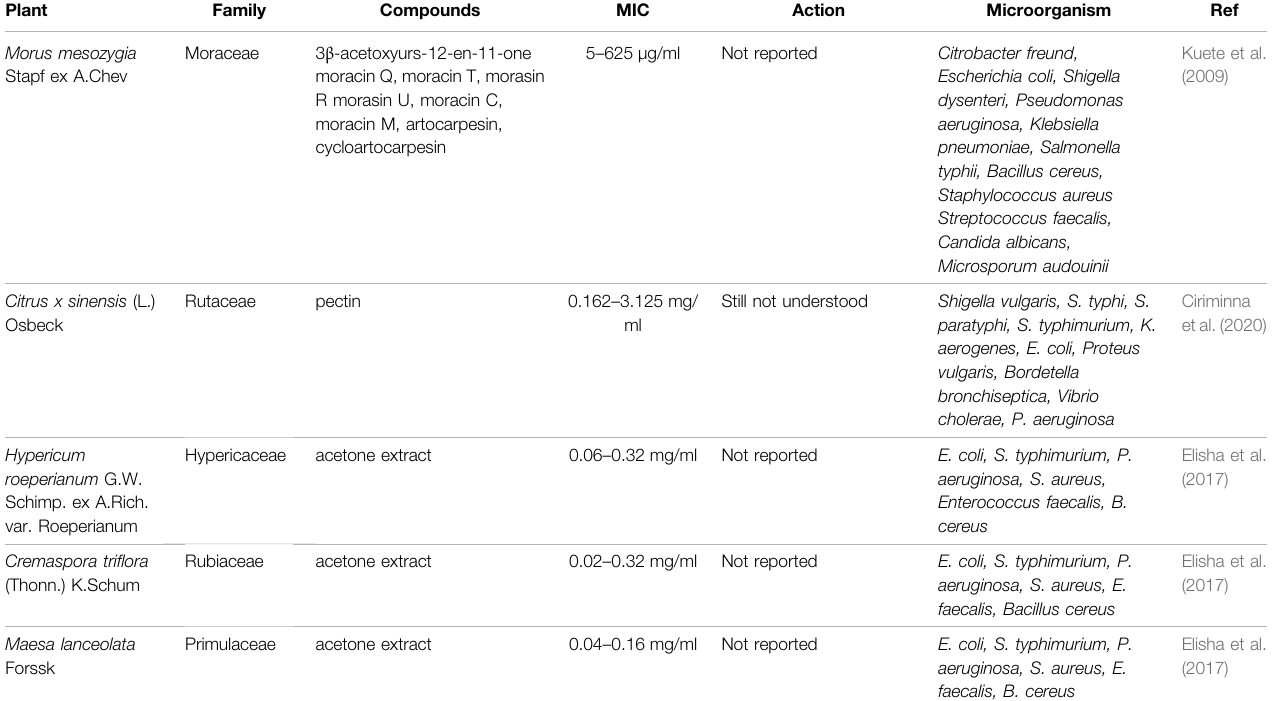
TABLE 1 | Plants with antimicrobial activity.